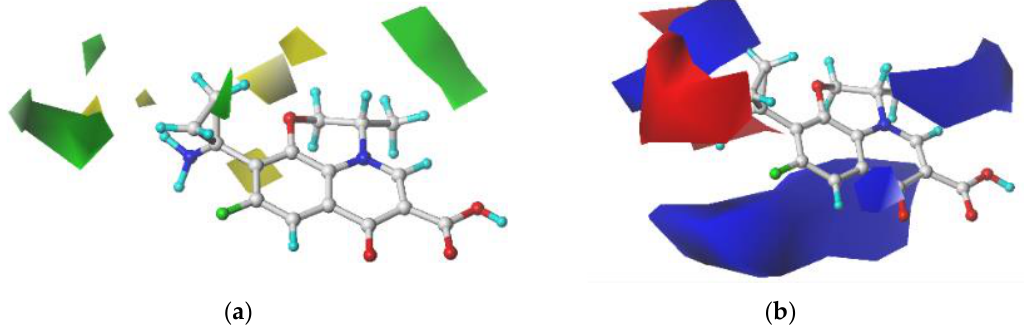
Figure 7. Contour maps of the CoMFA model, steric fields ( a ); electrostatic fields ( b ).